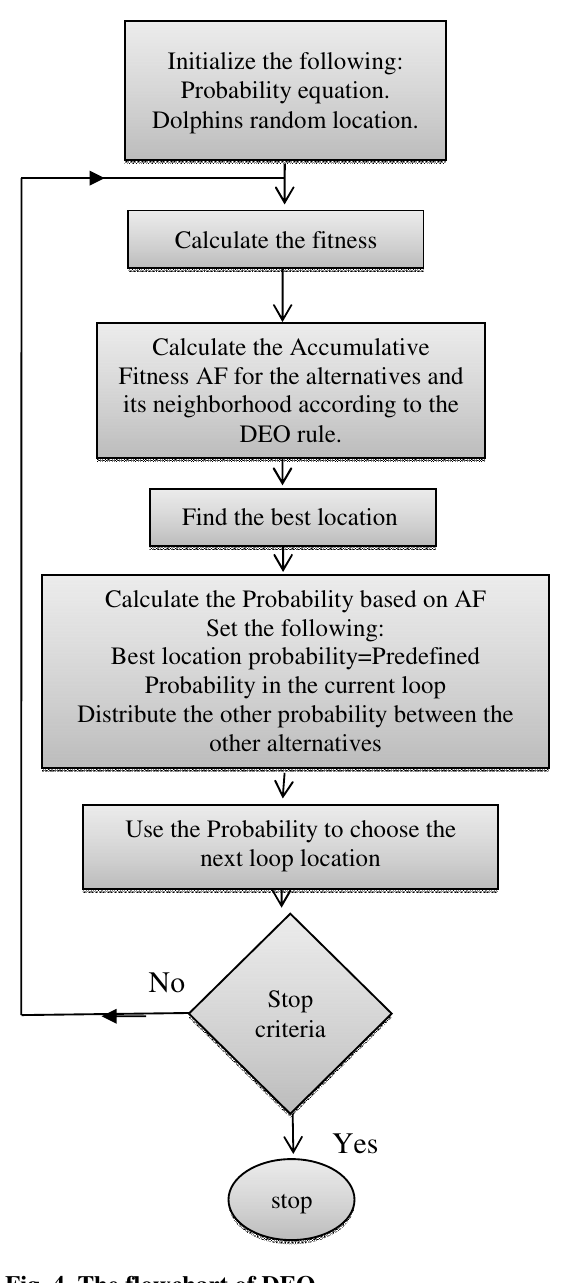
Fig. 4. The flowchart of